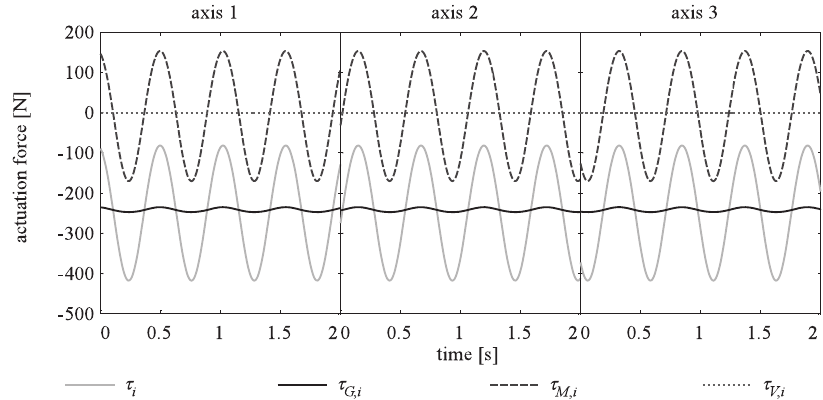
Figure 12. Di ff erent contributions to the total actuation e ff orts during a horizontal circular motion at maximum allowed thrust.